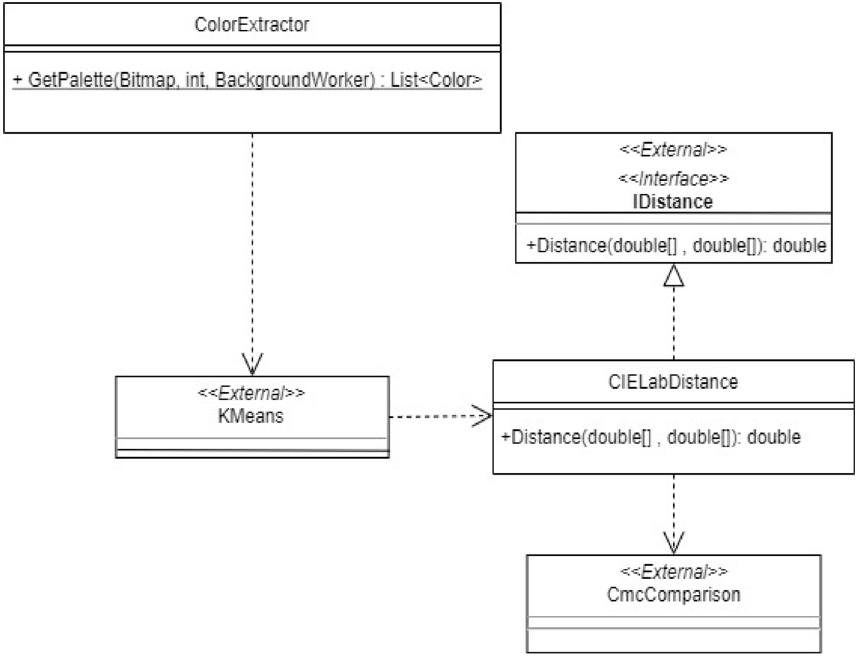
Figure 11. Class diagram for ColorExtractor component in logic layer of CammoGenerator